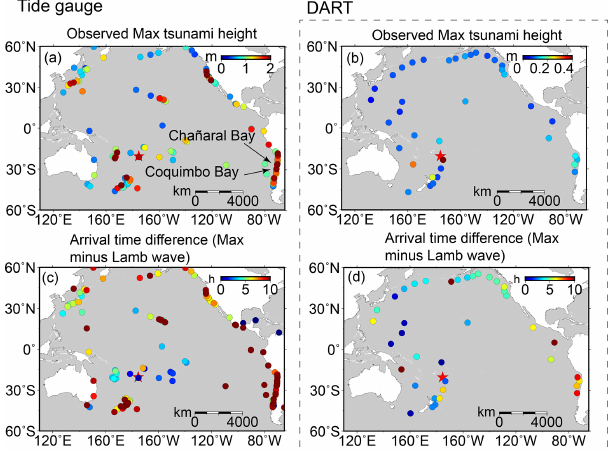
Figure 4. The spatiotemporal signatures of the 2022 HTHH tsunami across the Pacific Ocean. (a) Observed maximum tsunami height (trough-to-crest height) of tide gauges. (c) Arrival differences be- tween the maximum tsunami height of tide gauges and Lamb waves. Panels (b) and (d) are the same as (a) and (c) but for DART